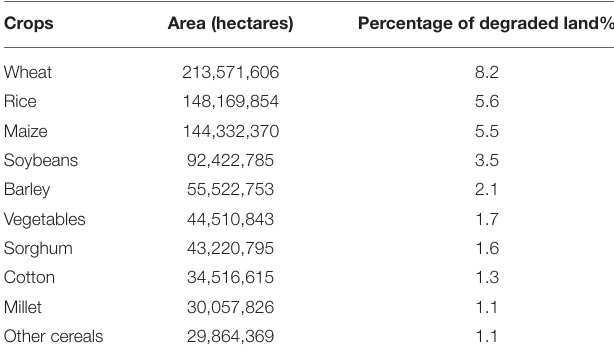
TABLE 1 | The 10 most represented crops present in degraded